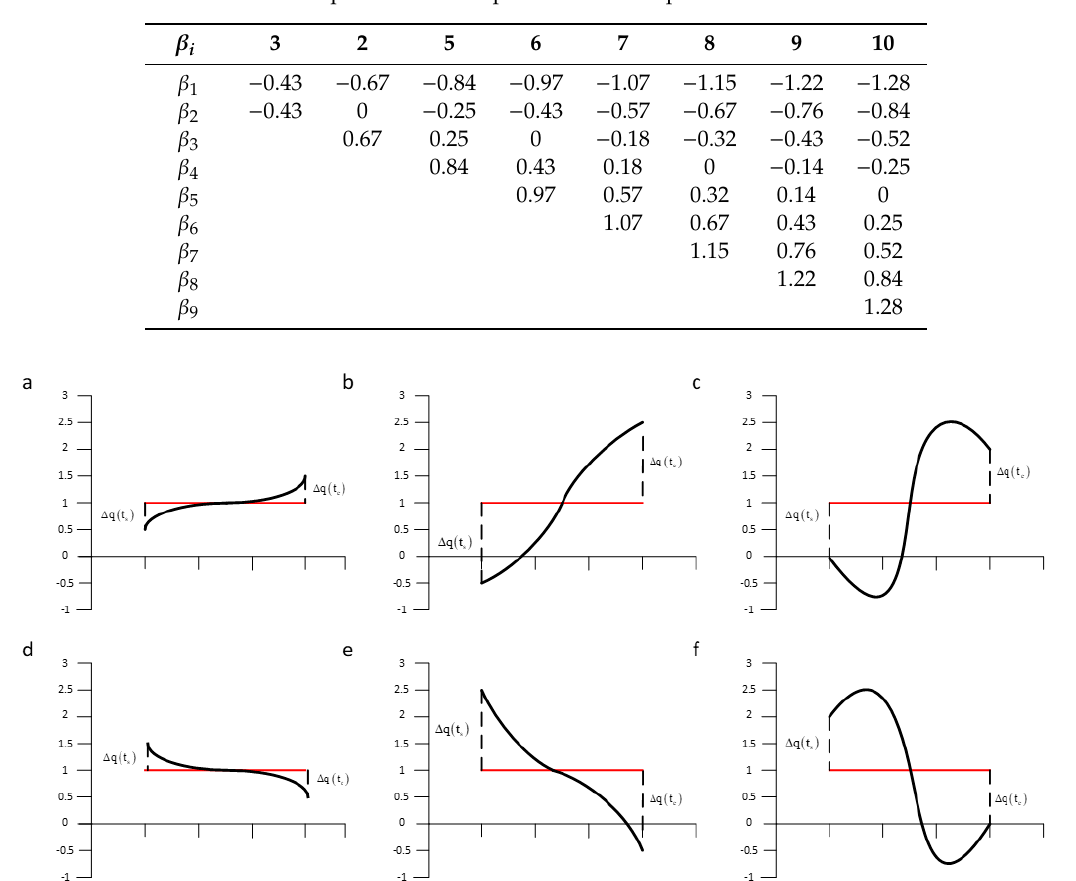
Table 1. A lookup table for breakpoints with the alphabet size from 3 to 10.